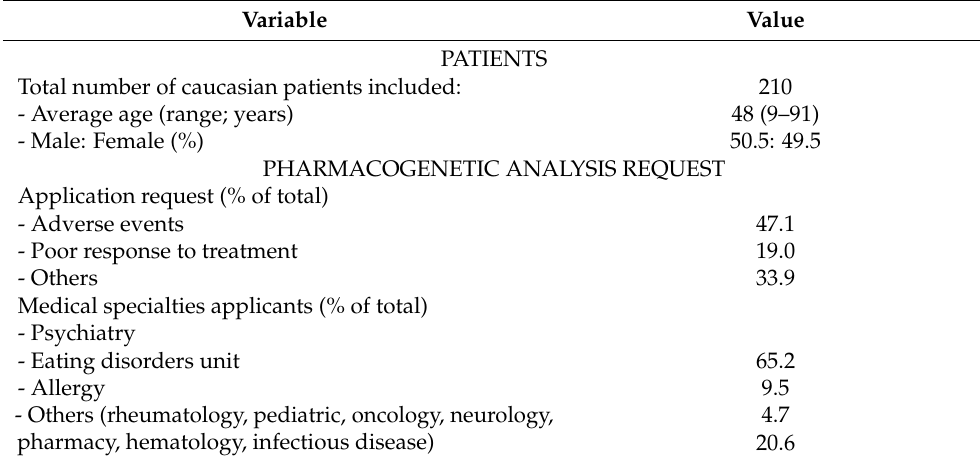
Table 1. Demographics and medication request. Variable Value